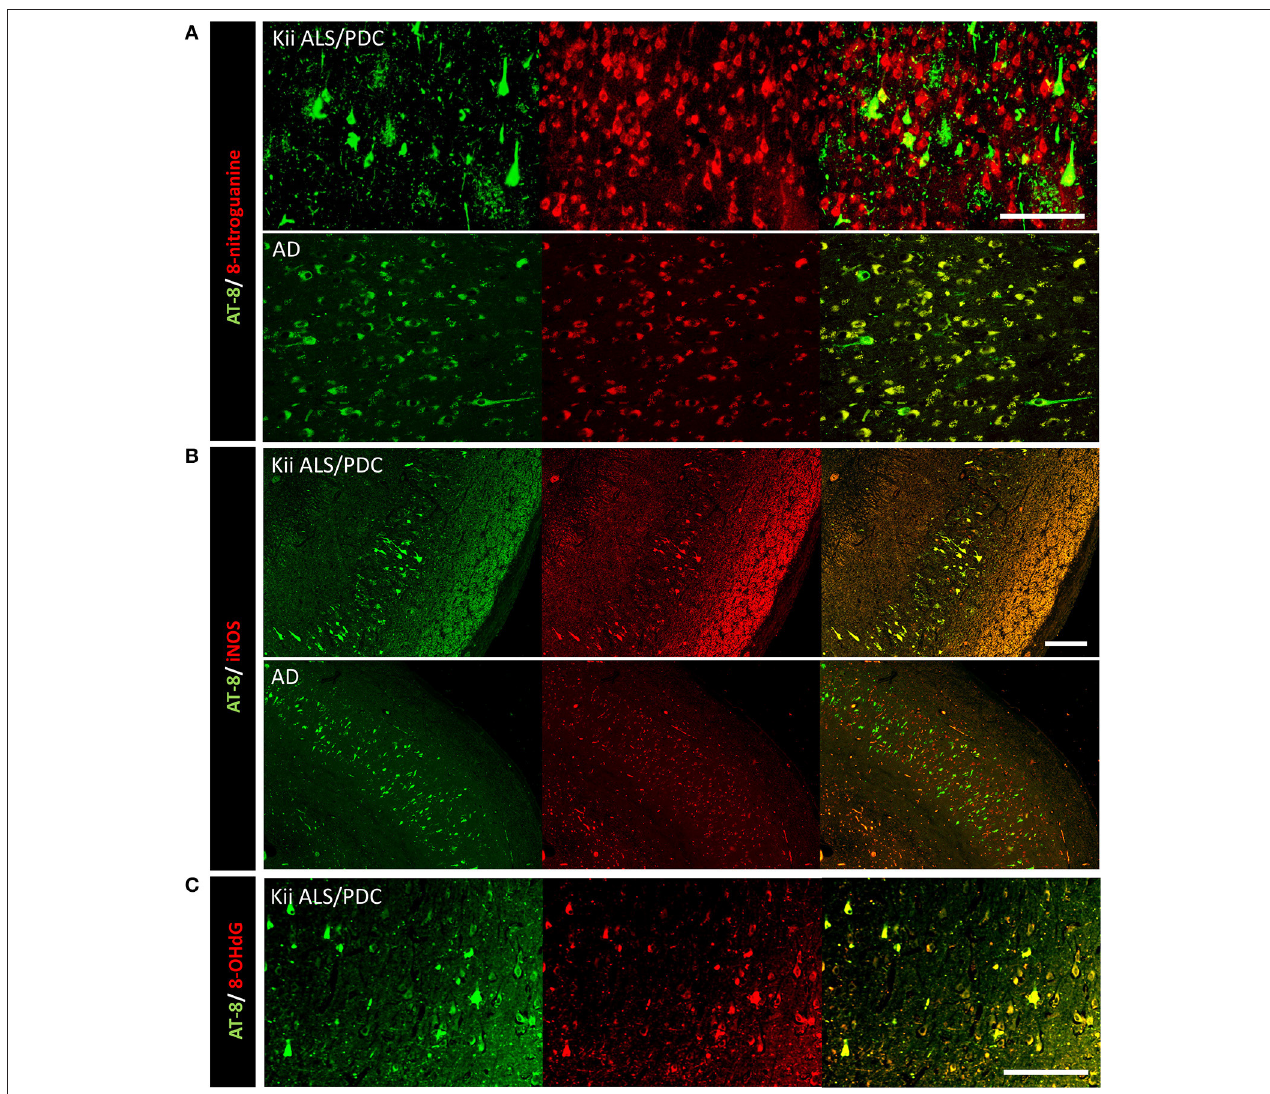
FIGURE 1 | Double immunofluorescence staining in the hippocampus of patients with Kii ALS/PDC and Alzheimer’s disease. (A) AT-8 and anti-8-NG antibody. (B) AT-8 and anti-iNOS antibody. (C) AT-8 and anti- 8-OHdG antibody. (A : × 200, B : × 100, C : × 200, scale bars represent 50 µ